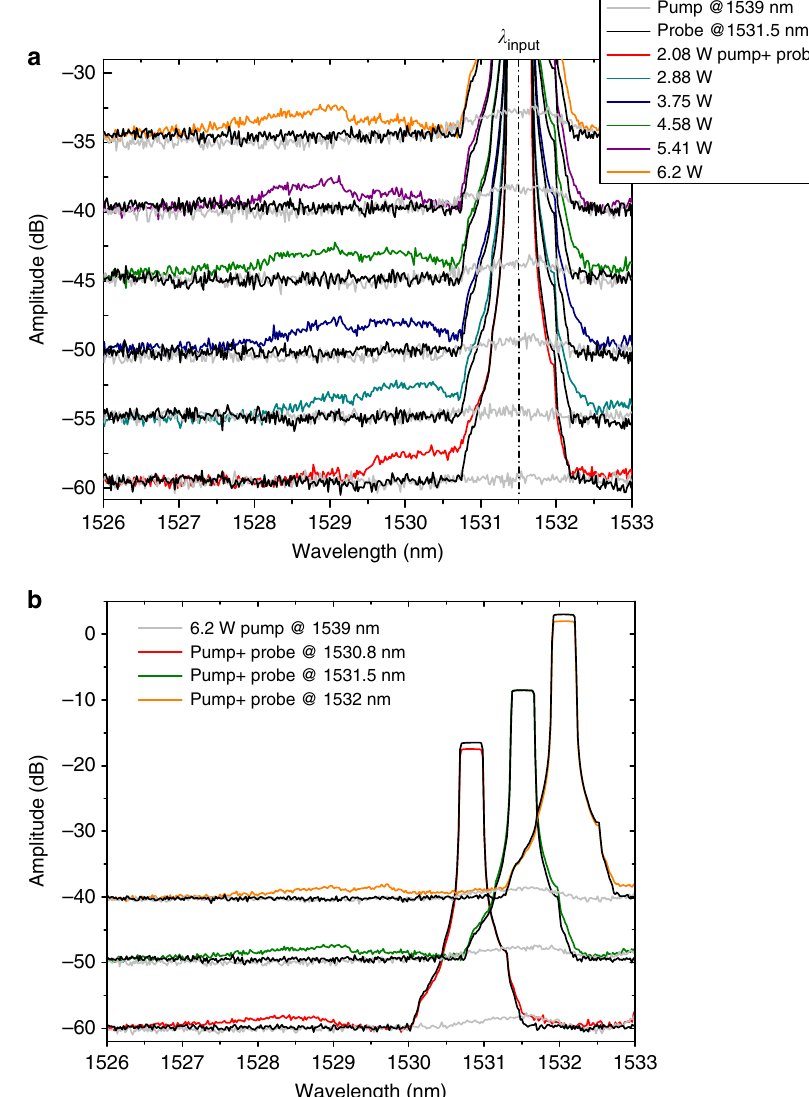
Fig. 3 Experimental spectra recorded at the output of our 396 µ m-long slow light silicon PhC waveguide. a Pump pulse peak power-dependent output spectra for the blue-shifted light of an input probe wave at a wavelength of 1531.5 nm. Shown is the spectrum of the CW probe that has not interacted with the pump pulses (black traces), the spectrum of the pump pulses alone (grey traces), and shown are the spectra of both the pump pulses and the CW probe (other colours). b Spectra for different input probe wavelengths. The different curves in a , b are shifted by 5 and 10 dB, respectively for clarity, the noise level corresponds to − 60